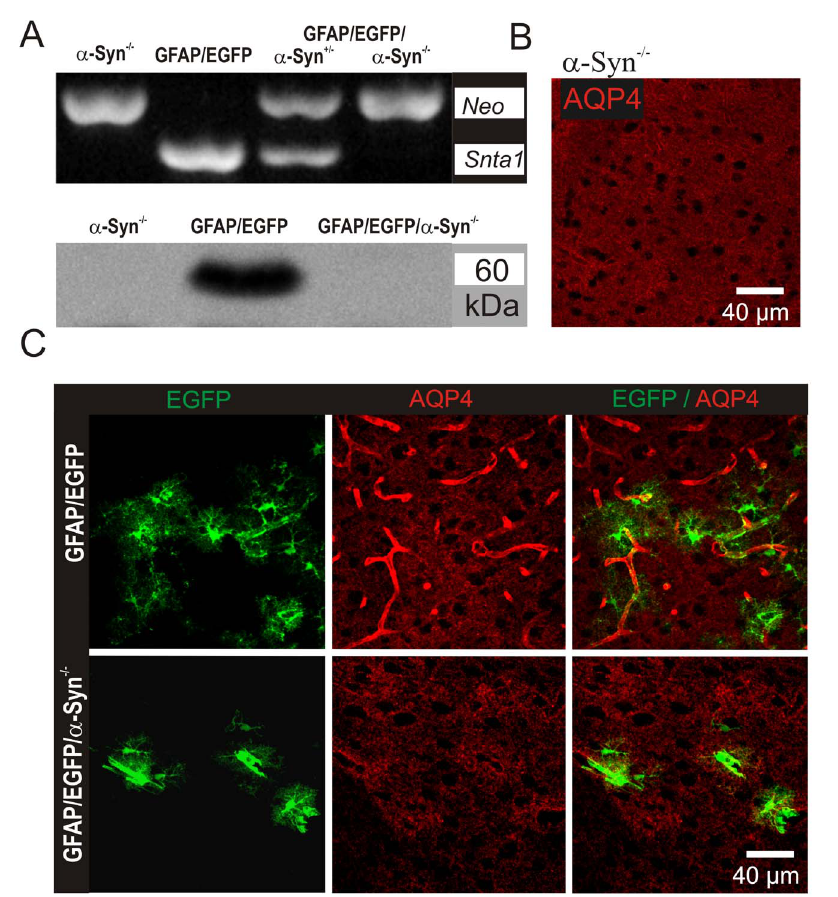
Figure 1. Characterization of double transgenic GFAP/EGFP/ a -Syn 2 / 2 mice. ( A ) PCR of tail genomic DNA isolated from a -Syn 2 / 2 mice, GFAP/EGFP mice, or double transgenic GFAP/EGFP/ a -Syn 2 / 2 mice. Mice lacking the Snta1 gene coding a -syntrophin also express Neo , the gene of neomycin resistance, inserted in the gene construct as a positive selectable marker during homologous recombination (top). Western blot analysis detecting a -syntrophin in cortical tissue isolated from a -Syn 2 / 2 mice, GFAP/EGFP mice, or GFAP/ EGFP/ a -Syn 2 / 2 mice (bottom). ( B ) Immunohistochemical staining for aquaporin 4 (AQP4) in cortical slices isolated from a -Syn 2 / 2 mice, ( C ) GFAP/EGFP mice or GFAP/EGFP/ a -Syn 2 / 2 mice. Note that a -syntrophin deletion is accompanied by the loss of AQP4 expression on the astrocytic membranes contacting blood vessels.